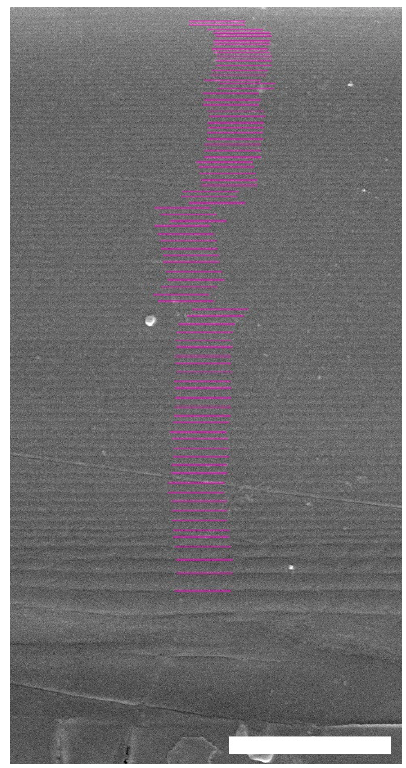
Figure 3. Scanning electron microscopy image of a cross-section through the cuticle of a C. optima scarab. The added violet lines, which cover a depth close to 17.2 μ m, indicate those planes where the chitin fibrils are parallel to the cut of the twisted structure. Scale bar: 5 μ m.